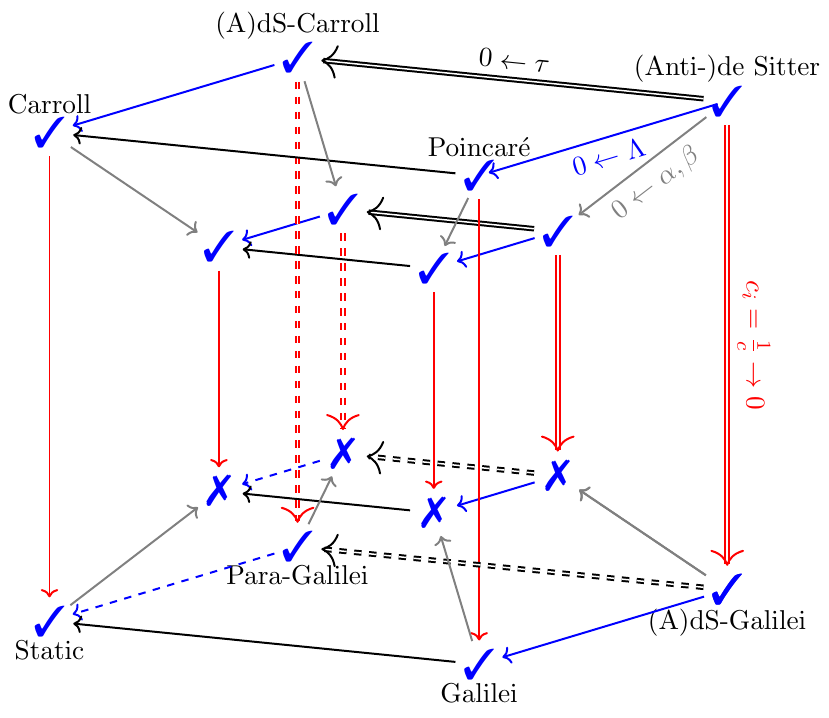
Figure 1 . This tesseract describes the limits starting with the (anti-)de Sitter theories extended by two (trivial) central extensions. They are added such that they are nontrivial in the nonrelativistic ( c i ! 0) limit and render all theories well-de(cid:12)ned ( 3 ) in the (cid:13)at ((cid:3) ! 0) and ultrarelativistic ( (cid:28) ! 0) limit. This spans the outer cube which is described in table 2. The (cid:11); (cid:12) ! 0 limit trivializes the central extensions and leads to the inner cube. The nonrelativistic theories are, unlike the carrollian, not well-de(cid:12)ned anymore. This is due to degeneracy of their invariant metric as indicated by a cross ( 7 ) and can be seen in table 1. See also table 10 for a summary of the properties of the algebras appearing in the